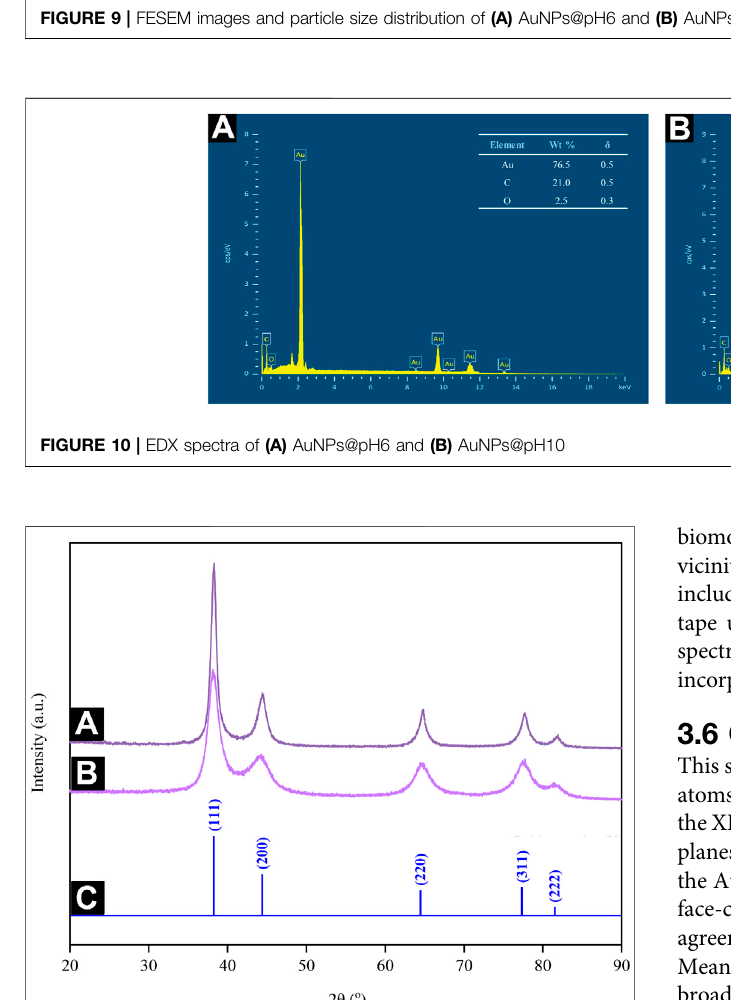
Frontiers in Chemistry |